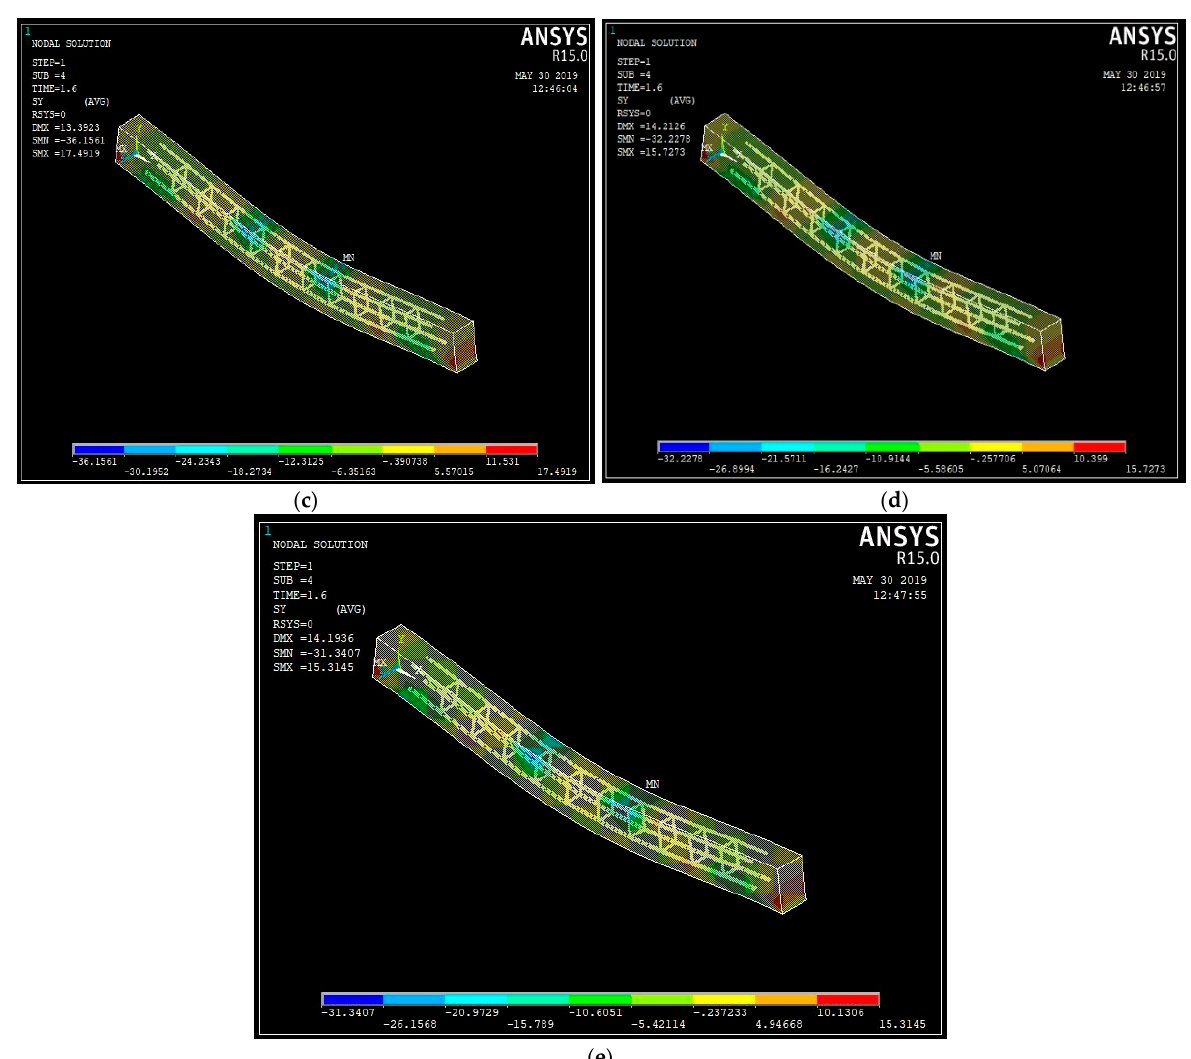
Figure 13. The stress contour of the steel fiber-reinforced coconut shell concrete beams: ( a ) CS; ( b ) CSF25; ( c ) CSF50; ( d ) CSF75; ( e ) CSF100.